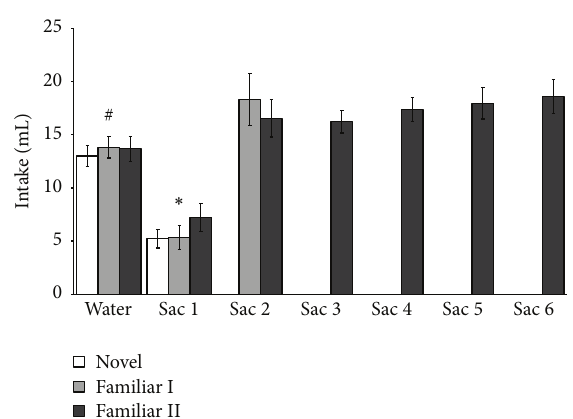
Figure 1: Mean ( ± SEM) intake during the last day of water baseline (BL) and the six saccharin solution (Sac) exposure sessions. For clarity all the groups are included in the figure but the statistical values correspond to group Familiar II ( ∗ versus Sac 2, 3, 4, 5, and 6, 𝑝 < 0.05 ; # versus Sac 1, 𝑝 < 0.05